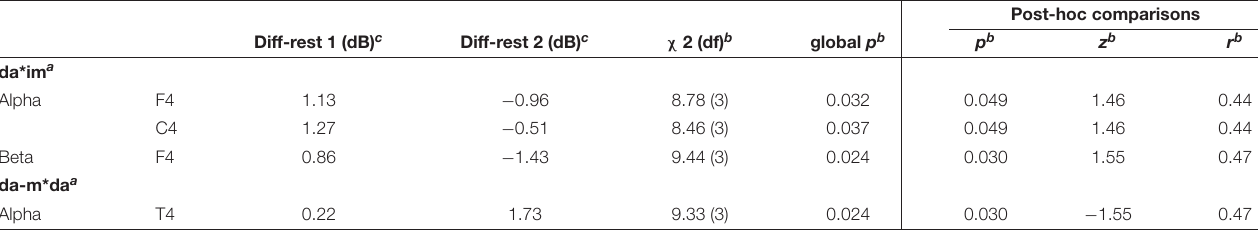
TABLE 2 | Significant differences between test conditions of power spectrum.